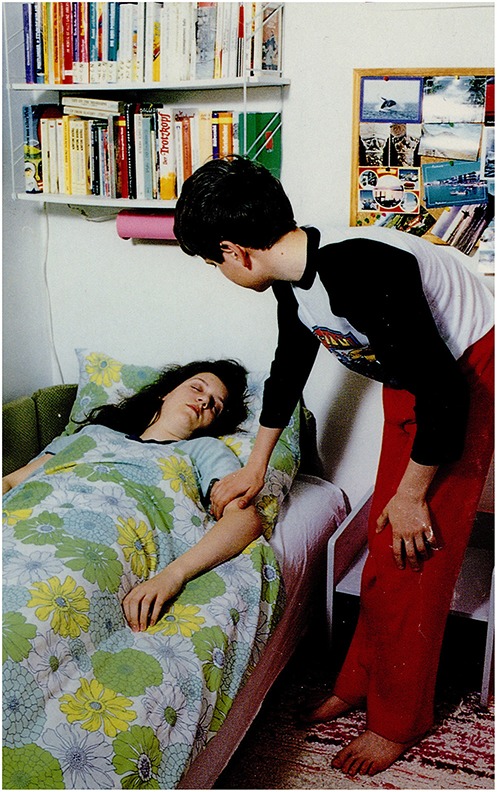
A boy is waking up a girl (Stark, 1998).